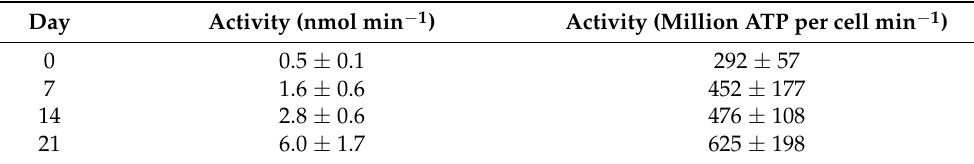
Table 3. Kinetic constants of ATP hydrolysis by MOVAS cells on days 0, 7, 14, and 21, determined from the IR spectra. ATP hydrolysis was induced by all ectoenzymes of MOVAS cells, including TNAP.